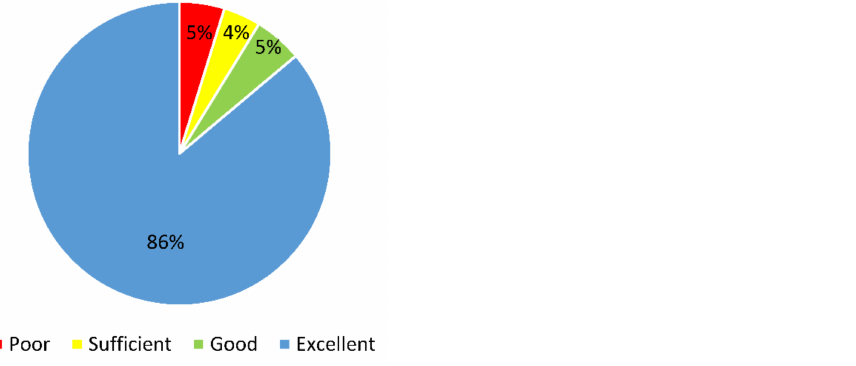
Figure 4. The percentage of bathing water quality categories for 2020 and 2021 bathing season.